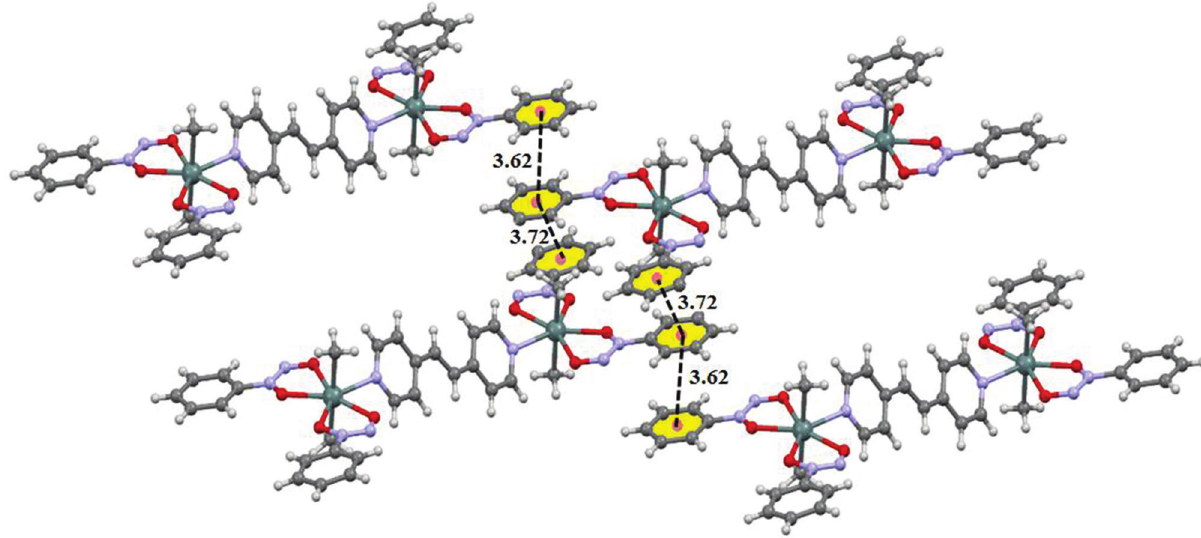
Figure 3: A perspective view of π–π interactions of tin complex.